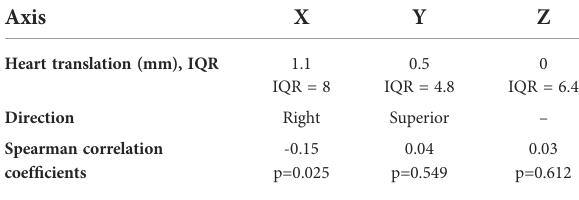
TABLE 1 Heart translation in each axis (X, Y, Z) and Spearman correlation coef fi cients.